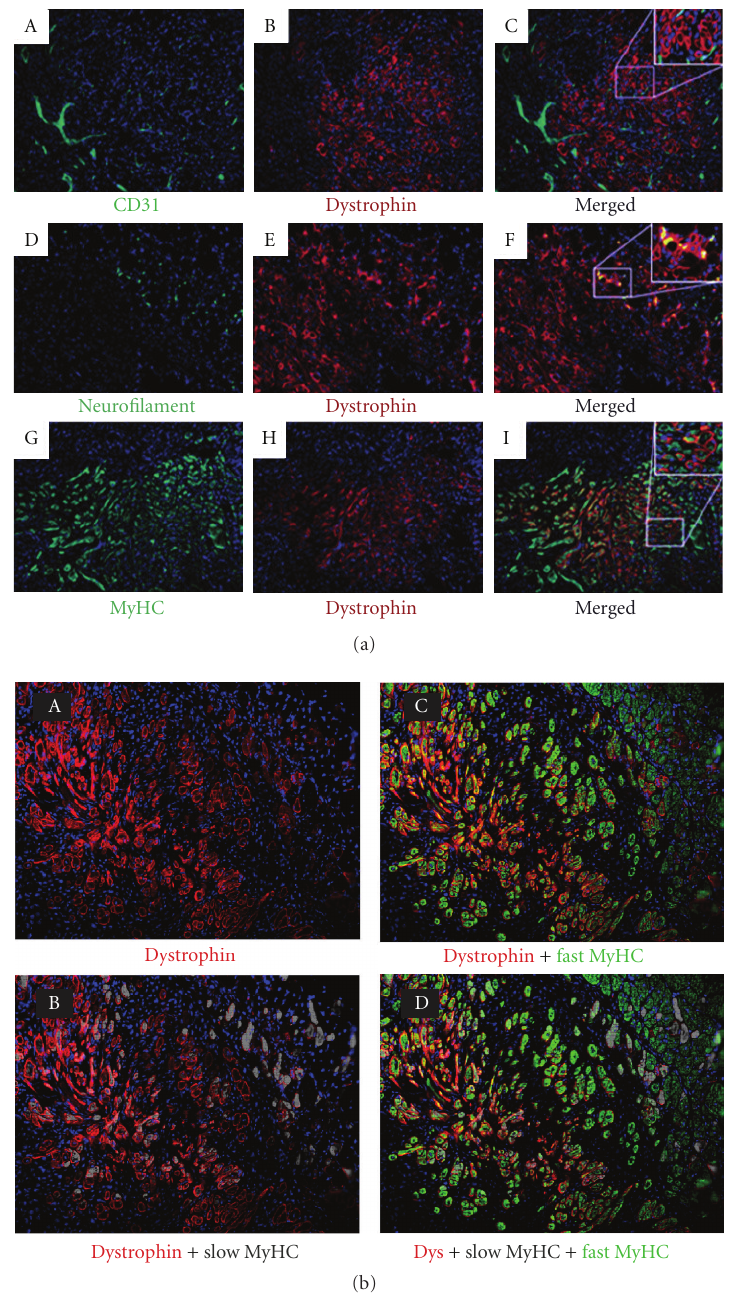
Figure 6: (a) Three months after implantation in vivo , large dystrophin-positive grafts were visualized ((a) B, E, H). CD31-positive cells were detected within the dystrophin-positive grafts indicative that vascularization and regeneration were occurring ((a) A–C). Neurofilament protein was visualized within the dystrophin-positive grafts revealing that innervations were forming along with the regenerating myofibers ((a) D–F). The majority of the dystrophin-positive grafts stained positively for fast myosin-heavy chain protein ((a) G–I). (b) Three months after implantation in vivo , all newly formed myofibers stained positive for dystrophin ((b) A dystrophin-red ). A small quantity of the dystrophin-positive myofibers stained positive for slow myosin-heavy chain protein ((b) B slow MyHC-gray ). A larger quantity of the dystrophin-positive myofibers stained positive for fast myosin-heavy chain protein ((b) C fast MyHC-green ). (b) D displays a merged image revealing the distribution of the two types of myosin-heavy chain